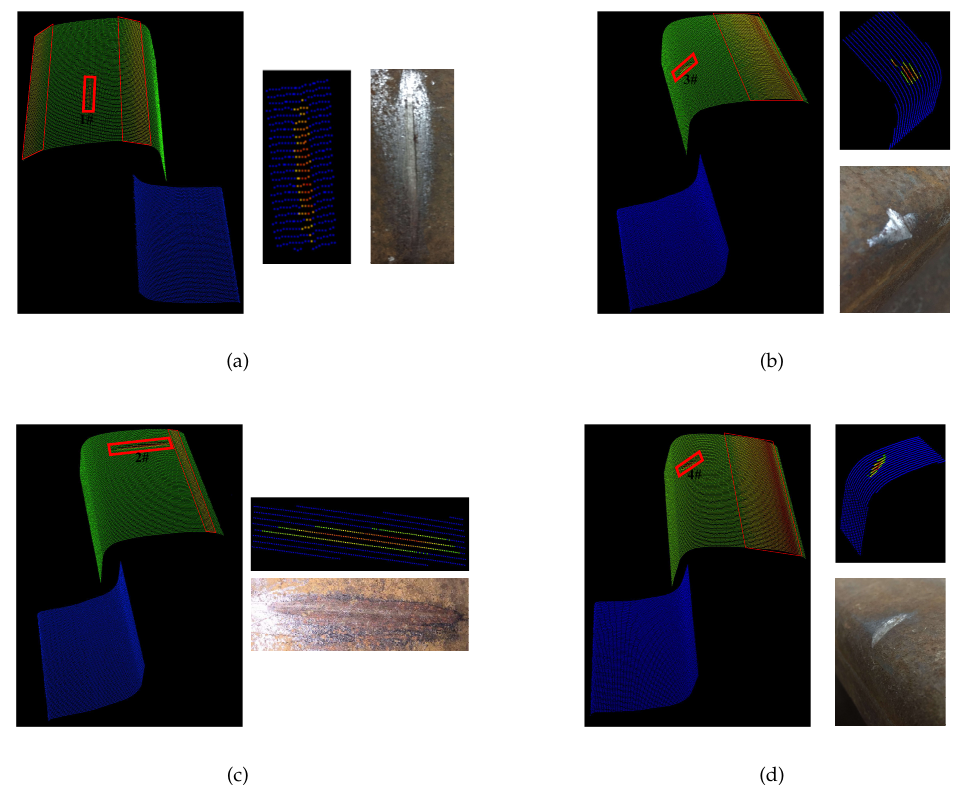
Figure 10. Examples of typical artificial defect extraction: ( a ) Vertical defects on the top; ( b ) Horizontal defects on the edge; ( c ) Horizontal defects on the top; ( d ) Sloping defects on the edge.